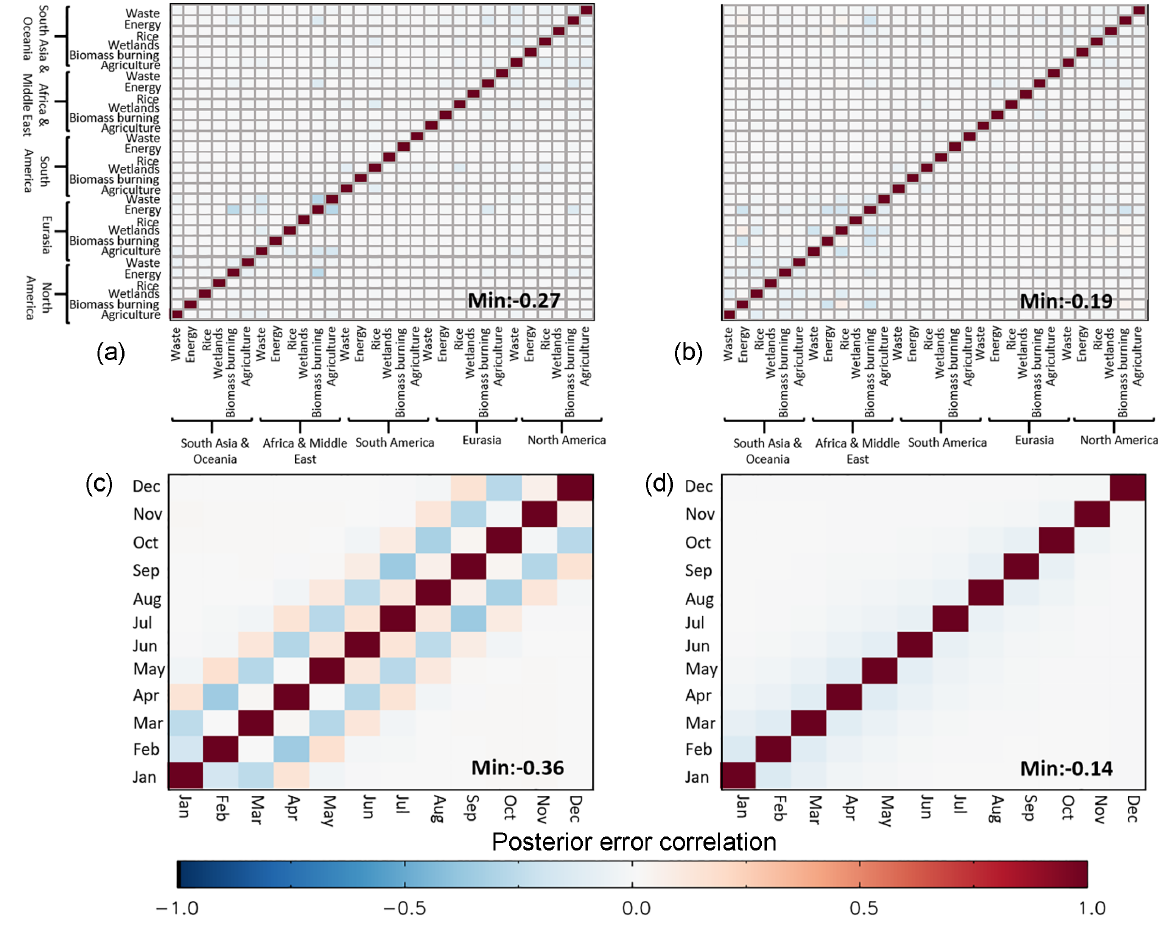
Figure 11. Posterior error correlation matrix for all regions and sectors for January (a) and July (b) 2015. Posterior error correlation matrix for 12 months in 2015 for the Eurasian energy sector (c) and South American wetlands (d) . The plots show a subset of the total posterior error correlation matrix as an example. Values are calculated by normalising the posterior covariances using the corresponding posterior standard